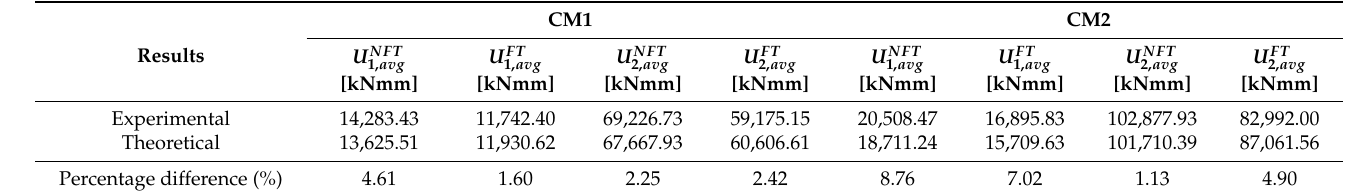
Table 6. Comparison between the experimental and theoretical average values of the two working capacity indices after the freeze–thaw cycles, U FT and U FT , and those before the freeze–thaw 2, avg 1, avg cycles of Ref. [42], U NFT and U NFT , for the CM1 and CM2 mixtures. 2, avg 1, avg